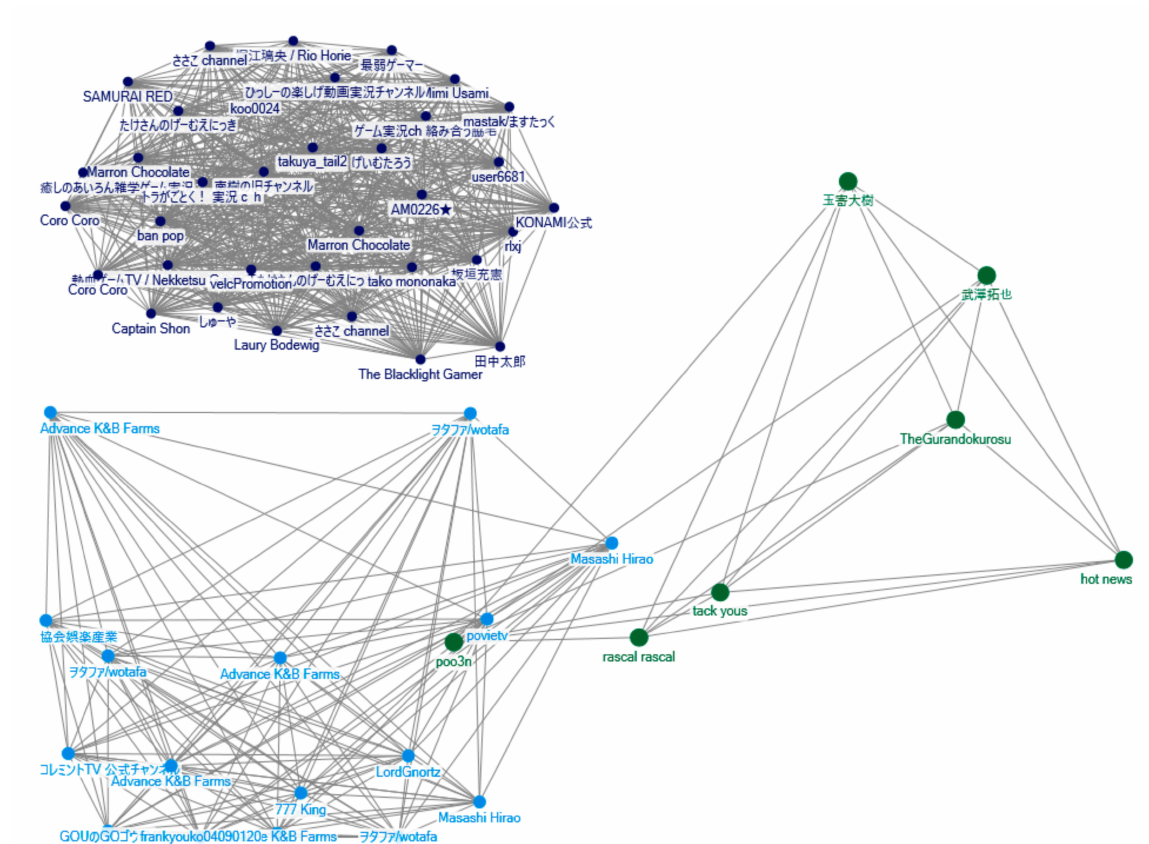
Figure 2. Node XL network regarding easy mode (rakuraku